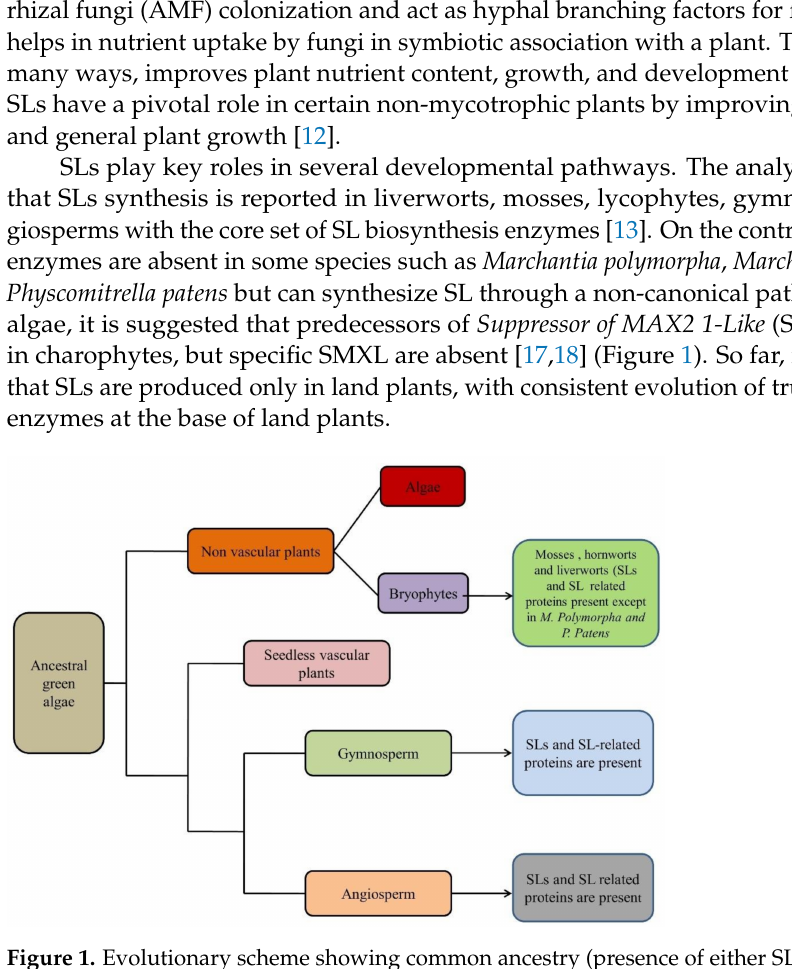
Figure 1. Evolutionary scheme showing common ancestry (presence of either SLs (strigolactones) or SLs-related proteins in land